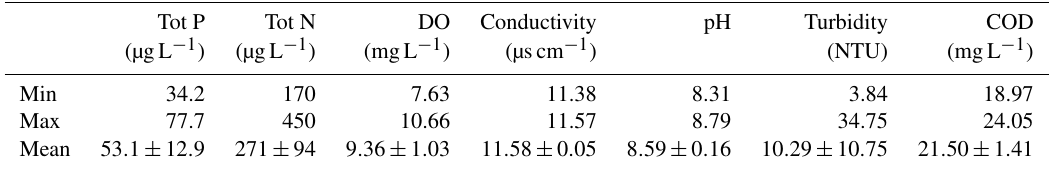
Table 6. Characterization (nutrients, DO, electrical conductivity, pH, turbidity, COD) of surface water from Malmfjärden Bay (mean ± SD; n =